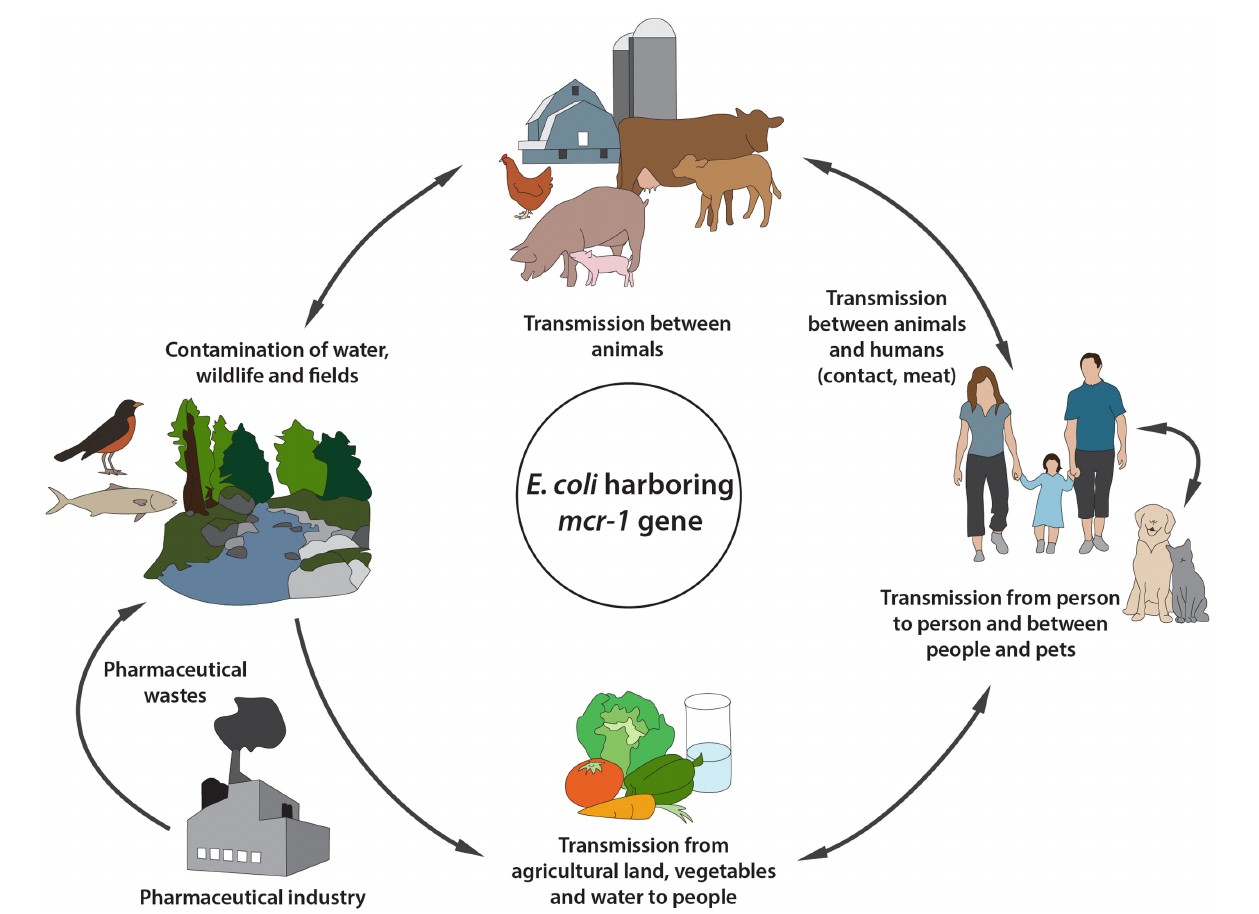
FIGURE 2 | Circulation of colistin resistant Escherichia coli harboring mcr-1 gene between animals-environment-food and